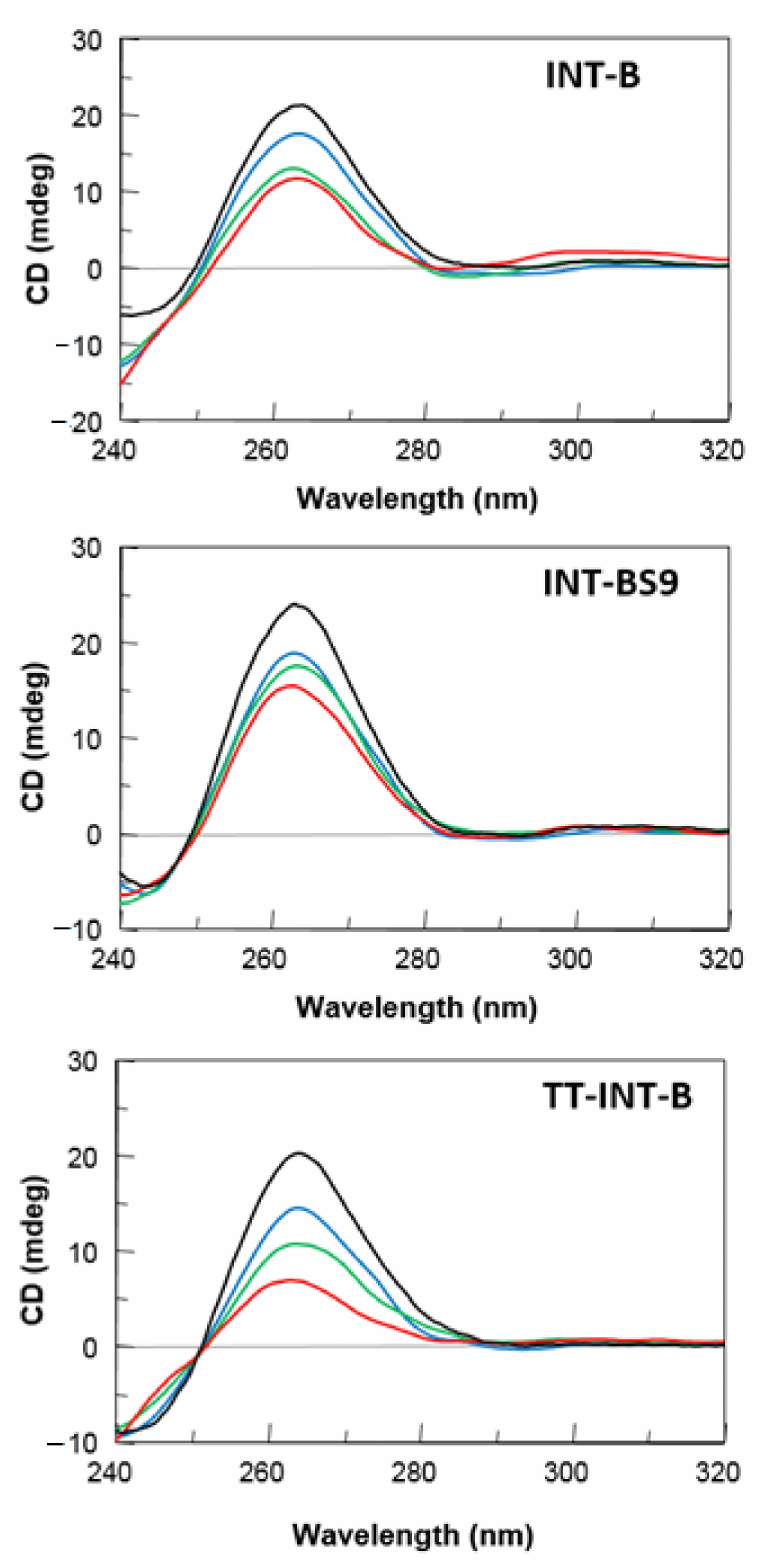
Figure 5. Representative CD spectra of INT-B , INT-BS9 , and TT-INT-B in 10% fetal bovine serum (FBS) diluted with Dulbecco’s Modified Eagle’s Medium (DMEM), registered at 0 (black), 24 (blue), 48 (green), and 72 h (red) at 37 ◦ C. See the main text and the Section 3 for